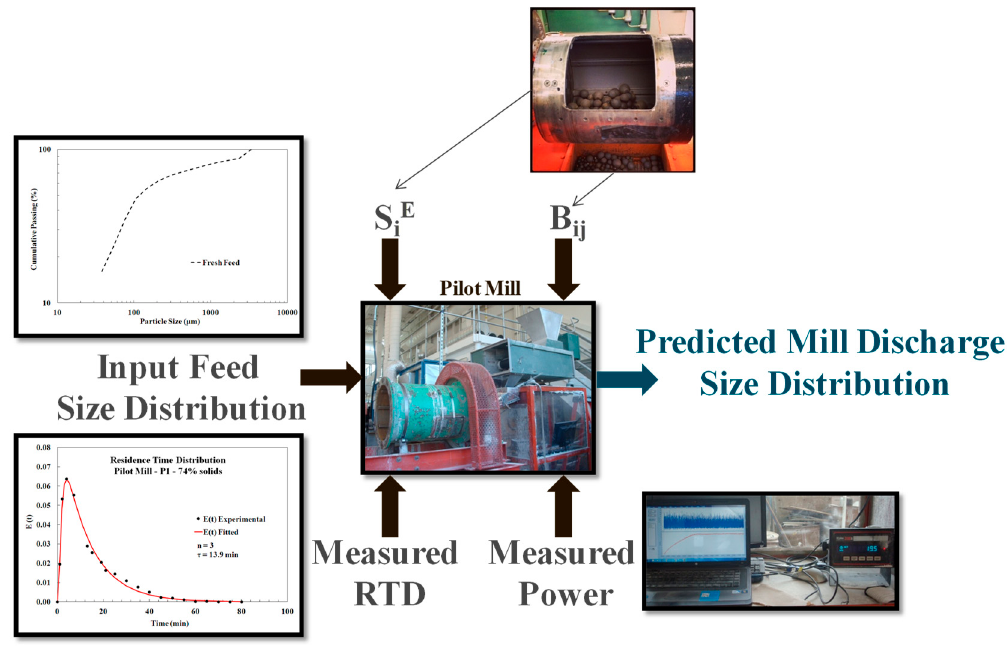
Figure 12. Prediction methodology scheme for the pilot scale mill.